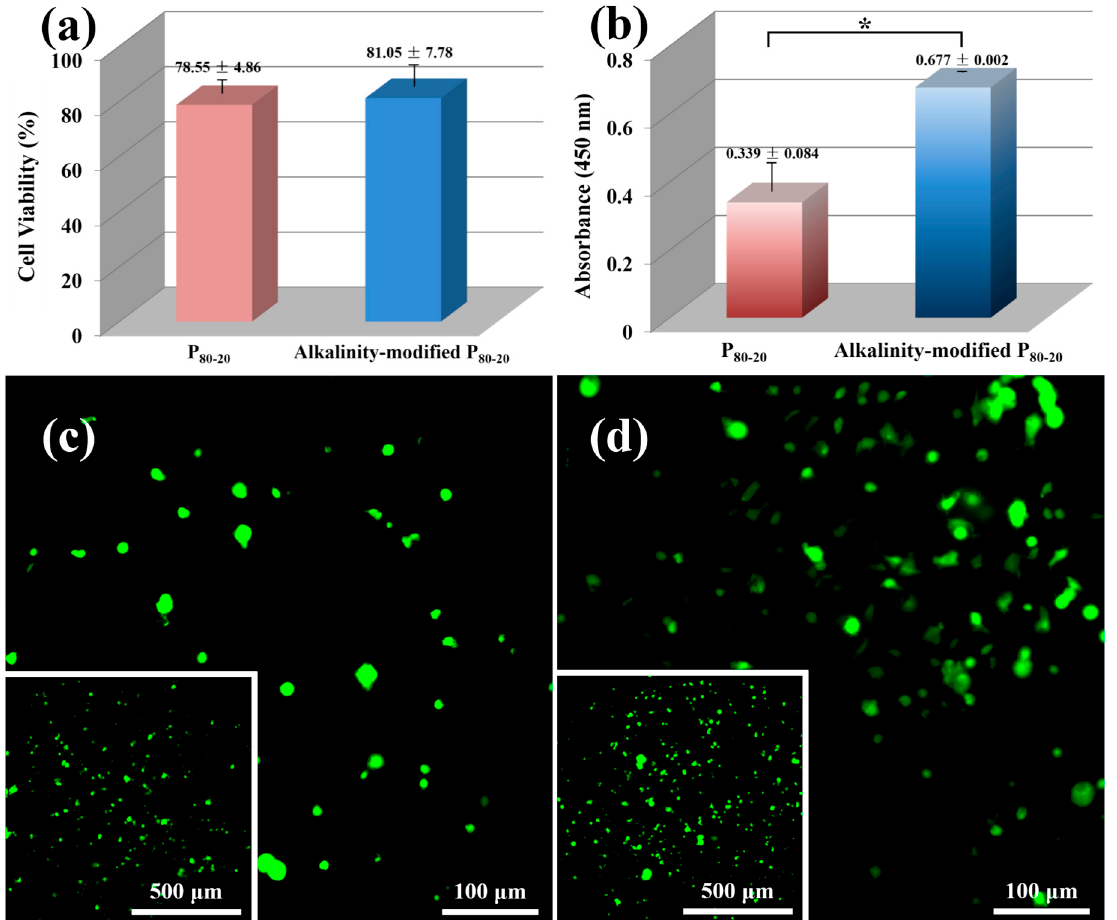
Figure 8. ( a ) Cytotoxicity of the scaffolds by extract solution analysis. ( b ) Cell adhesion of the scaffolds cultured for 1 day. Fluorescence image of bone marrow stromal cells (BMSCs) after adhesion on ( c ) P 80-20 and ( d ) alkalinity-modified P 80-20 (live cells are stained in green). The insets of ( c ) and ( d ) present low-magnification image of cell morphology. * indicates p < 0.05.